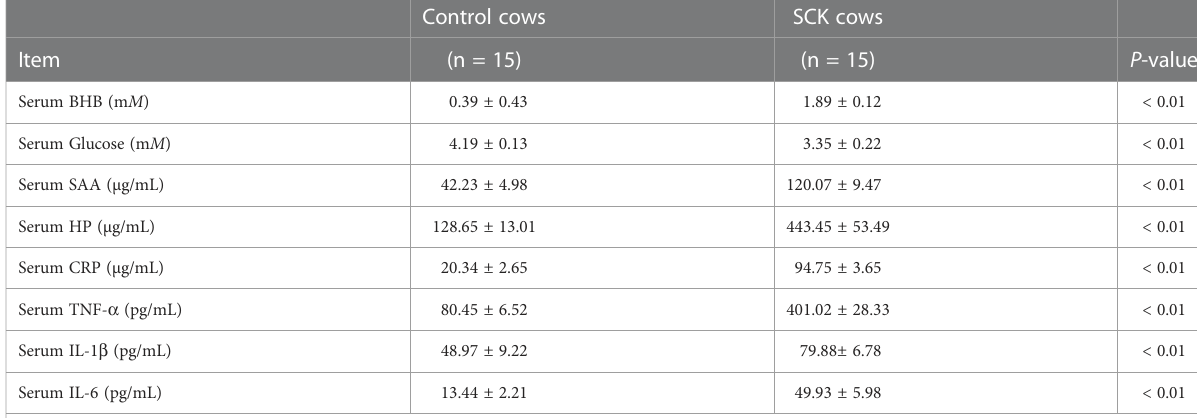
TABLE 1 Basic description of the control and SCK